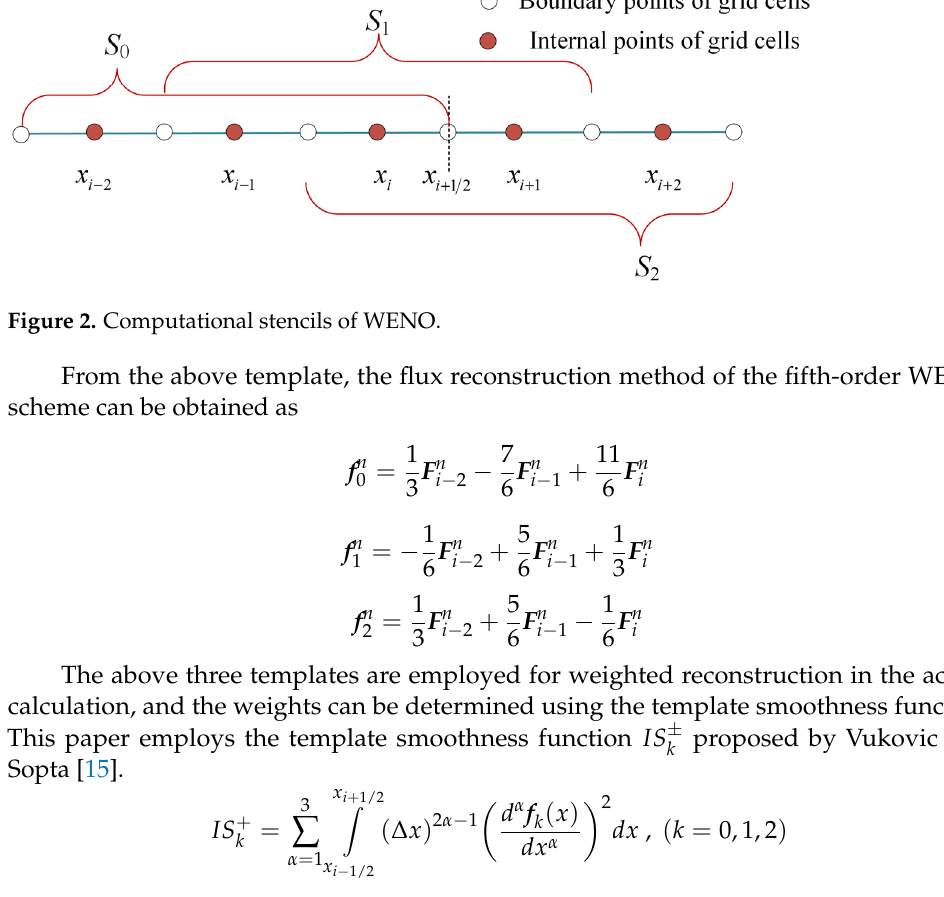
Figure 1. Schematic diagram of pipeline meshing.